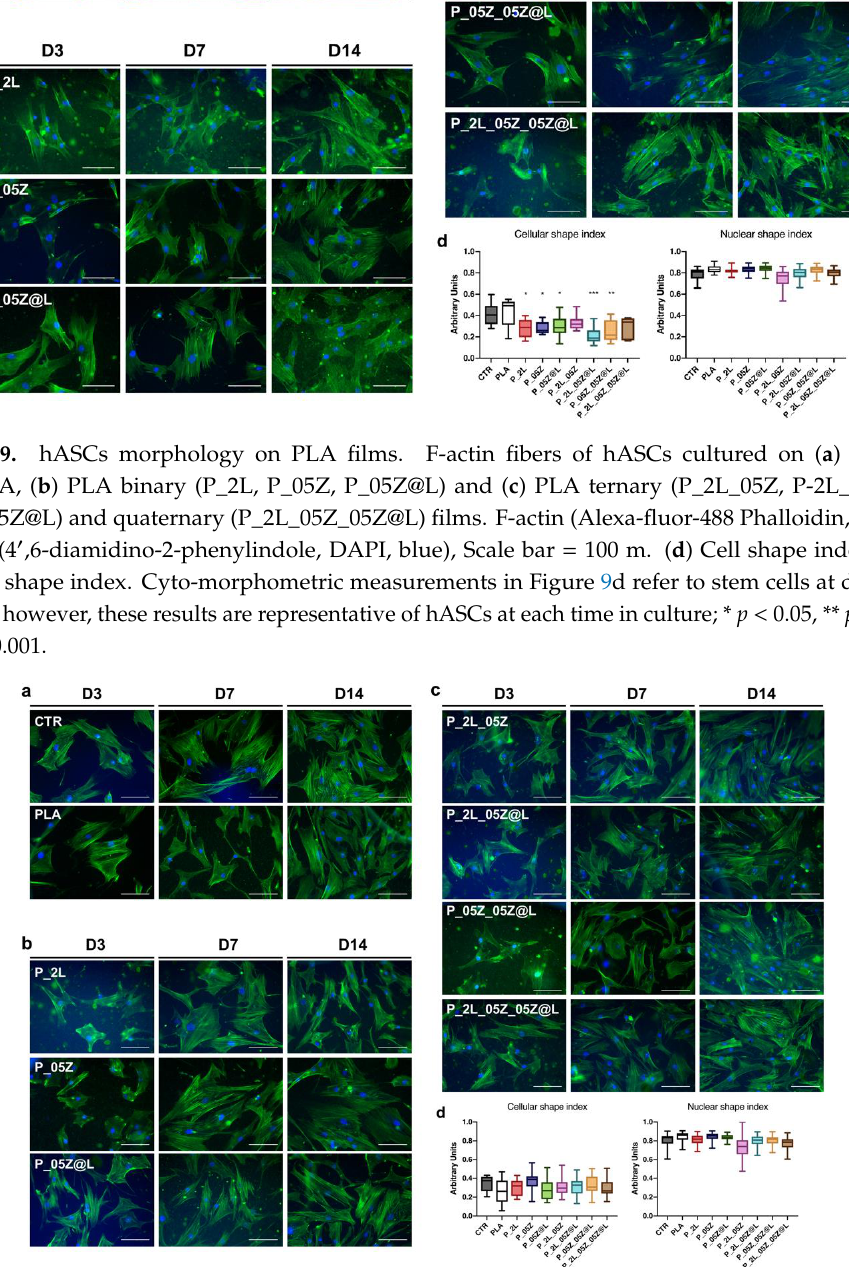
Figure 10. hBM-MSCs morphology on PLA films. F-actin fibers staining of hBM-MSCs cultured on ( a ) CTR and PLA, ( b ) PLA binary (P_2L, P_05Z, P_05Z@L) and ( c ) PLA ternary (P_2L_05Z, P2L_05Z@L, P05Z_05Z@L) and quaternary (P_2L_05Z_05Z@L) films. F-Actin (Alexa-fluor-488 Phalloidin, green), Nuclei (4 (cid:48) ,6-diamidino-2-phenylindole, DAPI, blue), Scale bar = 100 m. ( d ) Aspect ratio and nuclear shape index measures at 7 days in